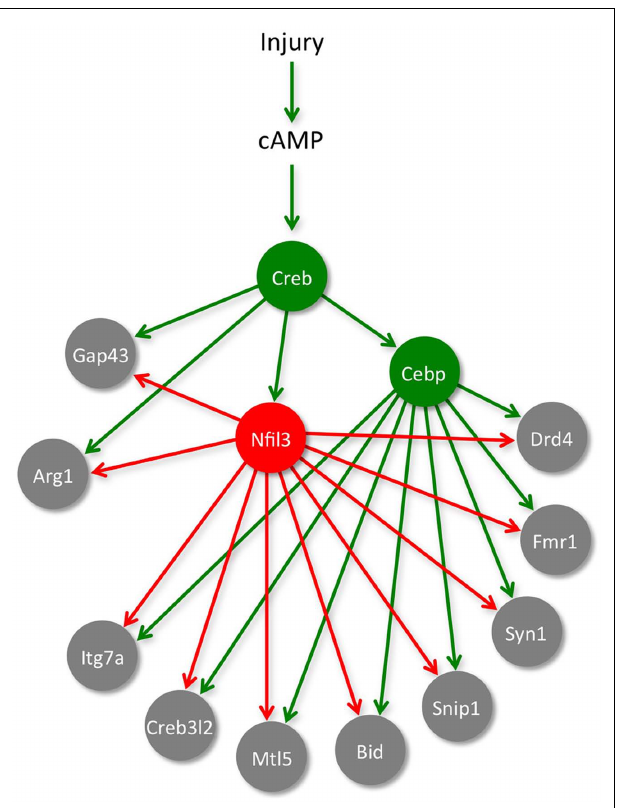
FIGURE 2 |A gene network for neuronal regeneration. Induction of cAMP levels and subsequent activation of CREB play an important role in starting up a RAG-response in injured neurons.We showed that one of the targets of CREB is anotherTF named NFIL3, and that NFIL3 functions as a feed-forward repressor of several CREB target genes (e.g., Arg 1 and Gap -43). In another study, we identified a set of RAGs (i.e., Itg 7 a , Creb 3 l 2, Mtl 5, Bid , Snip 1, Syn 1, Fmr 1, Drd 4) that are activated by C/EBPTFs, which are known downstream targets of CREB, and we showed that these RAGs are also repressed by NFIL3.We thus characterized a small part of the gene network that controls neuronal regeneration, and identified CREB, C/EBP, and NFIL3 as hub genes in this network. Downregulation of NFIL3 in neuronal cell lines or in adult primary DRG neurons significantly enhanced their regenerative